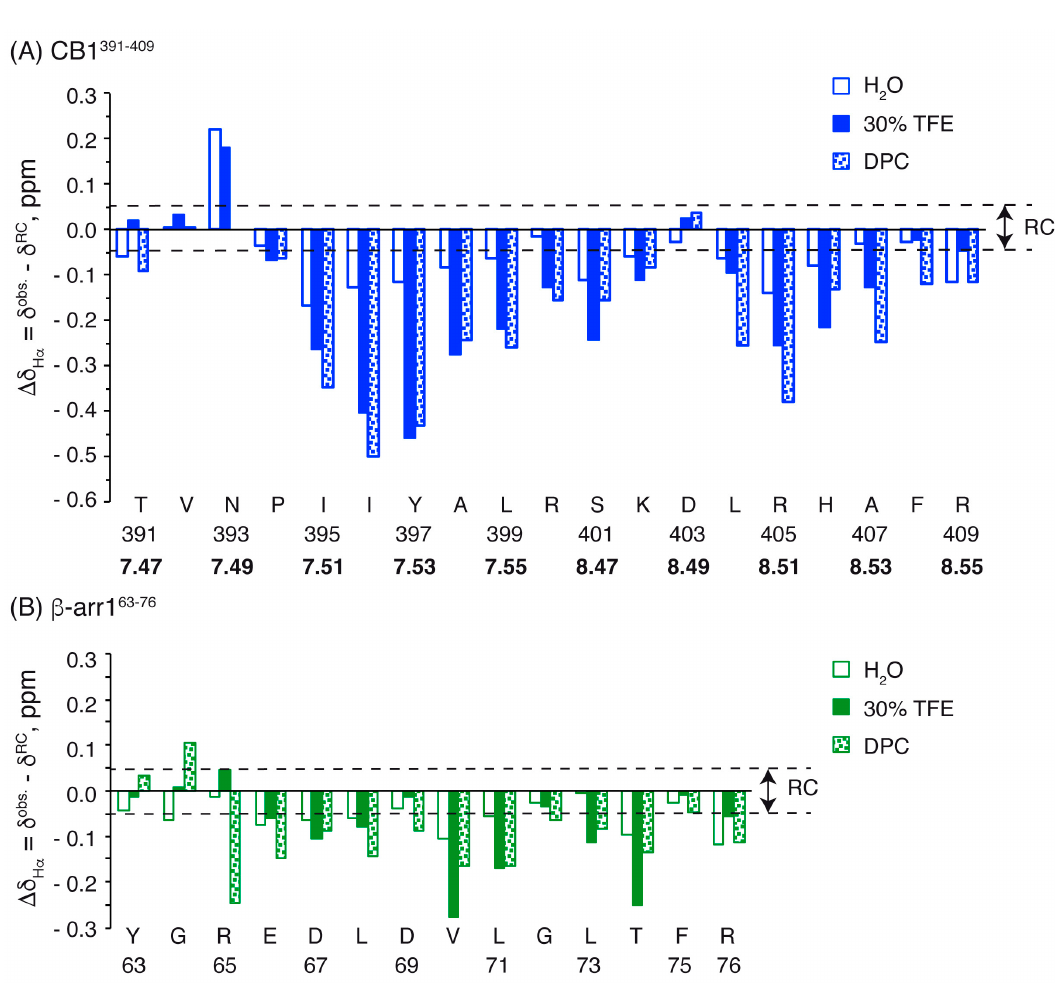
Figure 3. Δδ H α values plotted as a function of residue number for CB1 391-409 ( A ) and β -arr1 63-76 ( B ) in H 2 O (open bars), TFE (filled bars) and DPC (dotted bars) (30 mM). In all cases pH 5.5 and 25 °C. Dashed lines indicate the random coil (RC) range (| Δδ H α | ≤ 0.05 ppm). In the case of CB1 391-409 , the Ballesteros and Weinstein numbering is shown in bold.